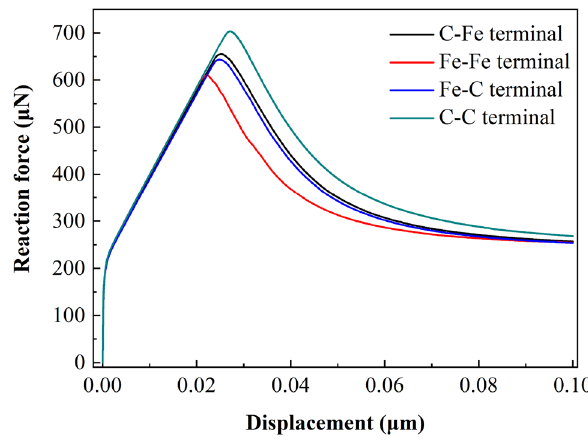
Figure 29. Displacement vs reaction force at loading point (10 μm × 8 μm).